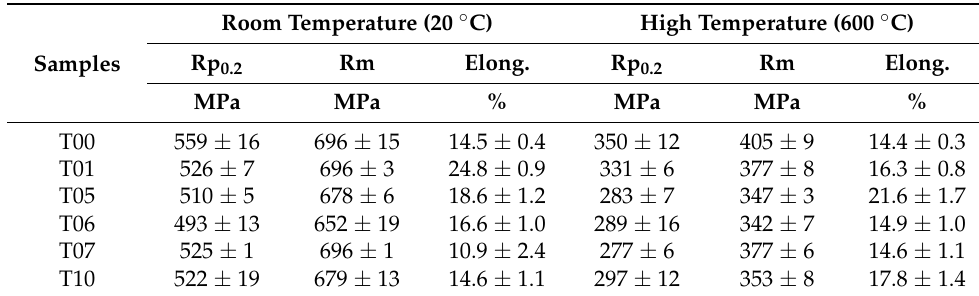
Table 9. Yield strength, ultimate tensile strength and elongation values for tensile tests carried out at room and high temperature (20 ◦ C and 600 ◦ C).